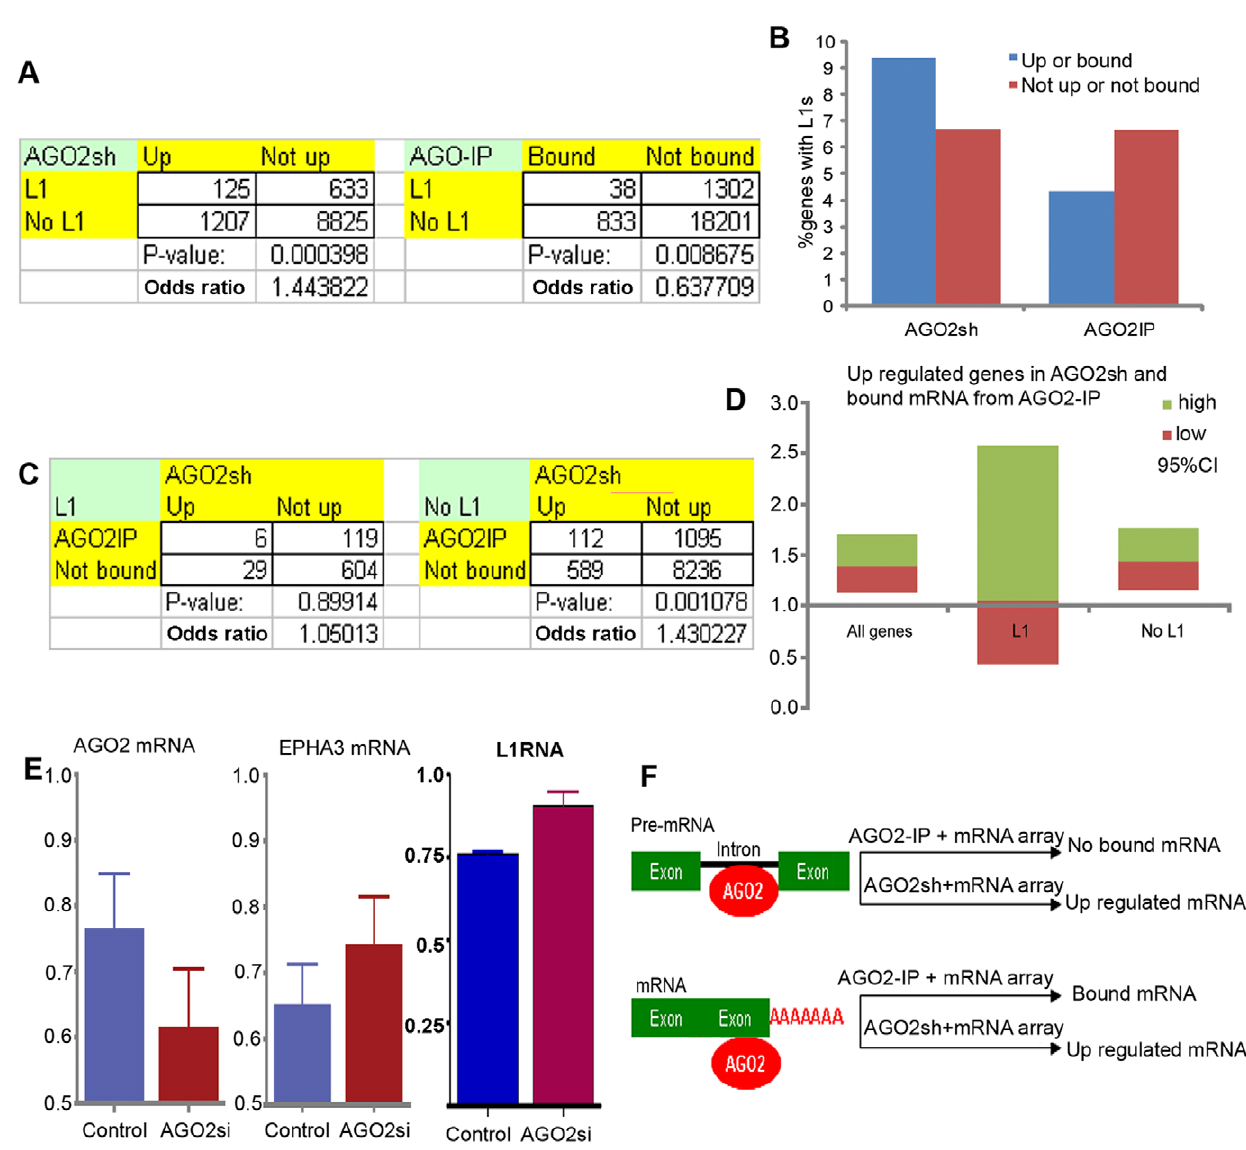
Figure 5. AGO2 and L1 RNA mediate intragenic L1 down-regulated gene expression in gene containing L1s. A) 2 6 2 tables, p values and odds ratios and B) percentages of L1 containing-genes that exhibit increased mRNA levels in AGO2sh-treated cells (‘‘Up’’) or are bound by AGO2 in AGO2IP (‘‘Bound’’), respectively. C) 2 6 2 tables, p values and odds ratios and D) odds ratios (95% CI) comparing HEK293T mRNA between up- regulated genes and not up-regulated genes upon AGO2sh and bound by AGO2 proteins for all genes (D), genes with L1s (L1) and genes without L1s (No L1), (C and D). D) The middle, top and bottom lines of each two-color box are the odds ratios and upper and lower 95% CIs, respectively. E) Levels of AGO2, EPHA3 mRNA and L1RNA in WSU-HN17 AGO2si cells. Data represent means 6 SEM. GSE records, GSM samples, type of t -test for A) and B) are given in Supporting Table S3. 2 6 2 contingency tables for C) and D) are given in Supporting Table S4. F) Two scenarios of AGO2-target binding reflecting in different mRNA array results when using AGO2-IP and AGO2sh as probes. Negative result was expected from mRNA expression microarray using AGO2-IP RNA as probes, (‘‘AGO2-IP + mRNA array’’), when introns of pre-mRNA were targeted. However, positive result was expected from mRNA expression microarray using mRNA from AGO2sh as probes, (‘‘AGO2sh + mRNA array’’), regardless AGO2 targets pre-mRNA or mRNA.